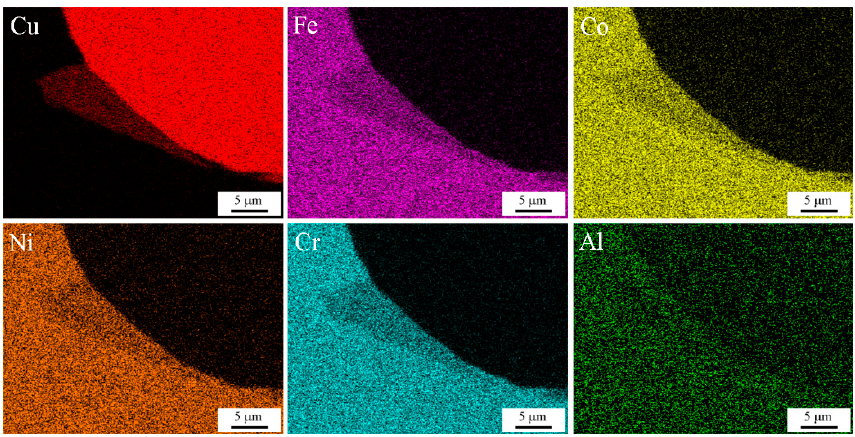
Figure 9. The element distribution corresponding to the back zone in Figure 7.